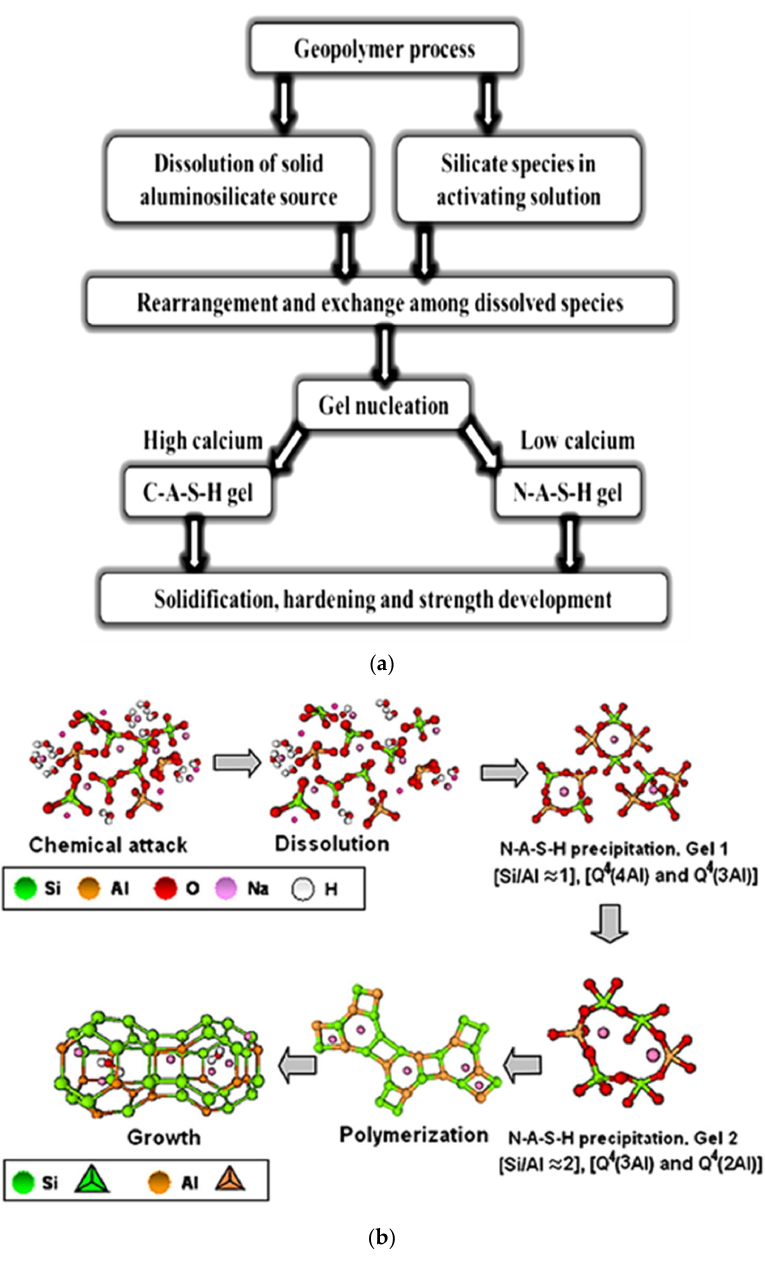
Figure 8. ( a ) A Provis conceptual model of geopolymerization [64,69]; ( b ) a Glukhovsky conceptual model for geopolymerization [70].